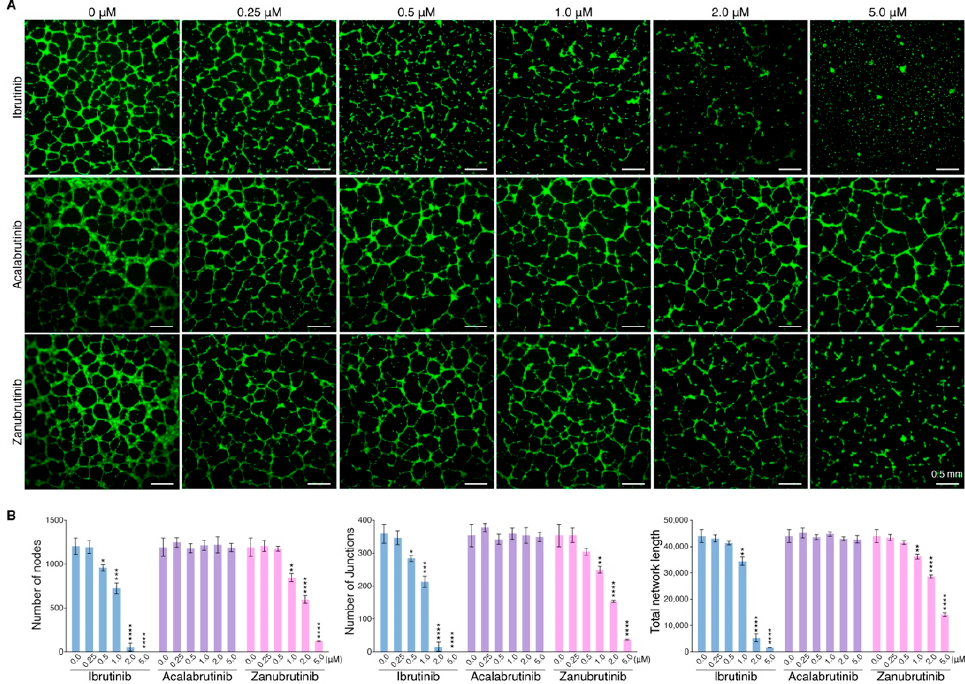
Figure 3. Effect of BTKis on endothelial network formation. ( A ) Endothelial cells were incubated for 8 h in Matrigel and treated with Ibrutinib, Acalabrutinib or Zanubrutinib in a dose-dependent manner and endothelial networks were observed under fluorescence microscopy after staining endothelial cells with Calcein AM. Scale bars, 0.5 mm. ( B ) Quantification of nodes, junctions and total network length of endothelial networks by ImageJ software ( n = 3). Data are shown as mean ± SEM; * p < 0.05; ** p < 0.01; *** p < 0.001; **** p < 0.0001, as calculated using the Student’s t -test.